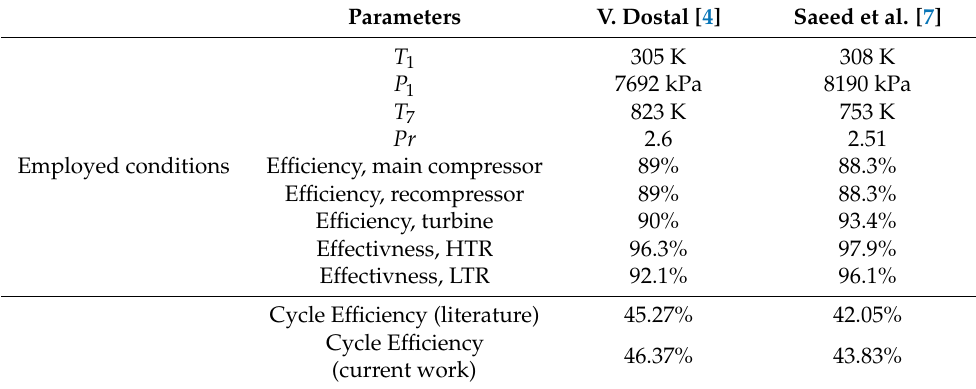
Table 4. Model validation.